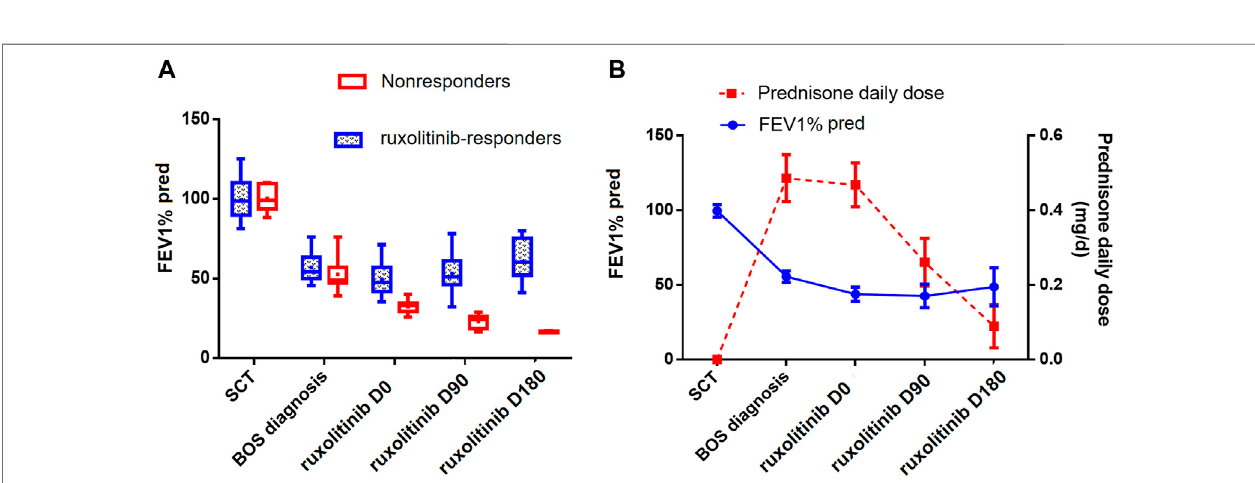
FIGURE 2 | Swimmer plot depicting response, duration of response, and patient outcome with ruxolitinib for all 30 patients.